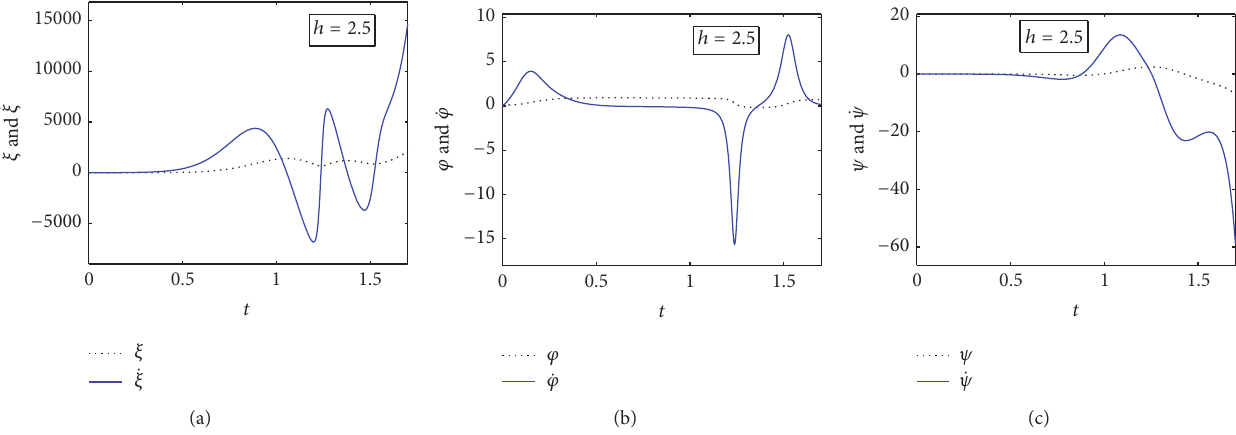
̇𝜉 ), ( 𝜑 and ̇𝜑 ), and ( 𝜓 and ̇𝜓 ) against time 𝑡 , respectively, at 𝑏 = 3 m, ℎ = 2.5 ,